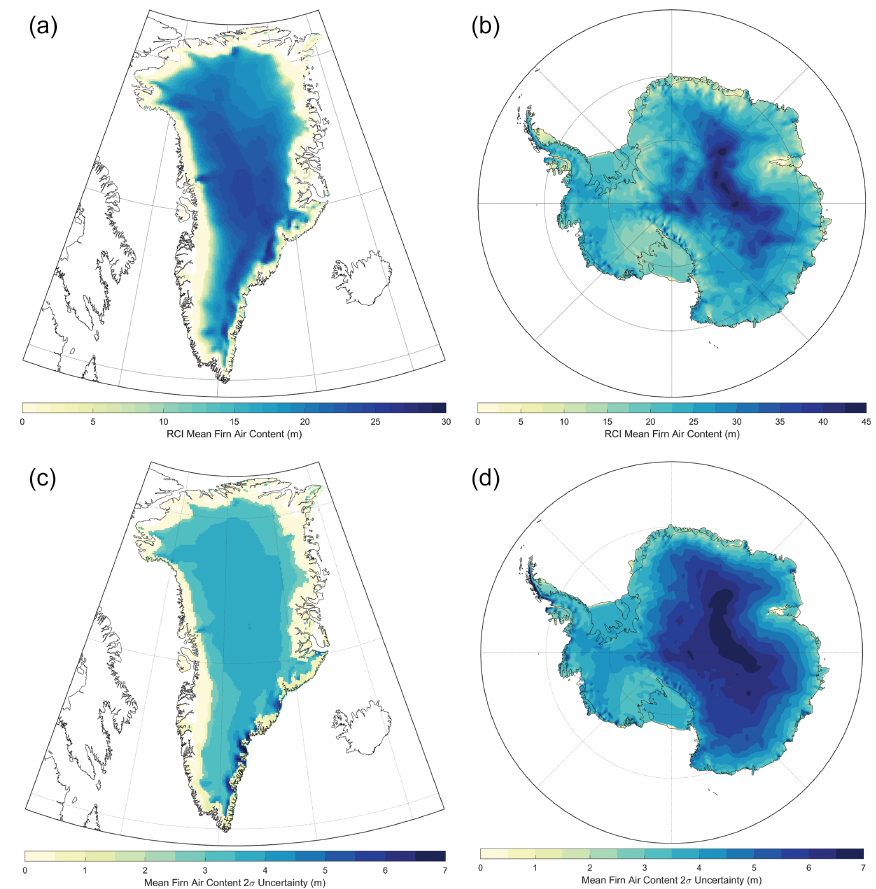
Figure 13. The mean firn air content (FAC) for the (a) Greenland Ice Sheet and (b) the Antarctic Ice Sheet over their respective refer- ence climate intervals and (c, d) the respective 2 σ uncertainty. Note the differences in color scale for Greenland and Antarctica and their